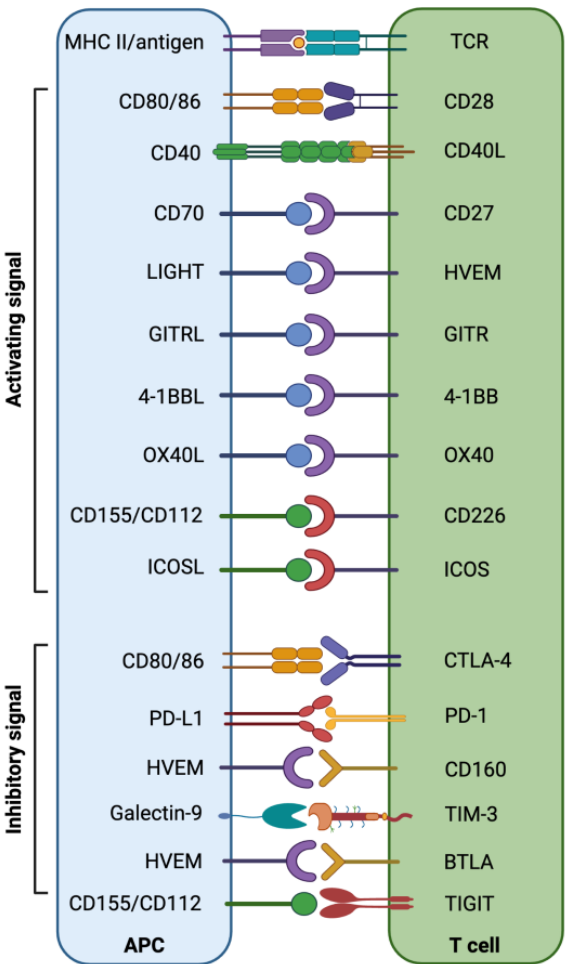
Figure 1. Interaction of co-stimulatory/inhibitory molecules between T cells and APCs/tumor cells provides an overview of the immune checkpoint/stimulatory molecules involved in the anti-tumor immune response.